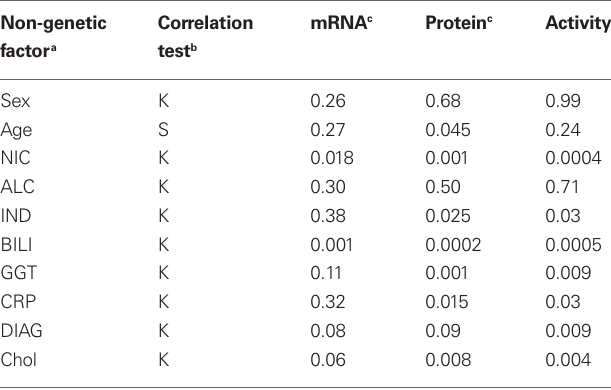
Table 3 | influence of non-genetic factors on CYP1A2